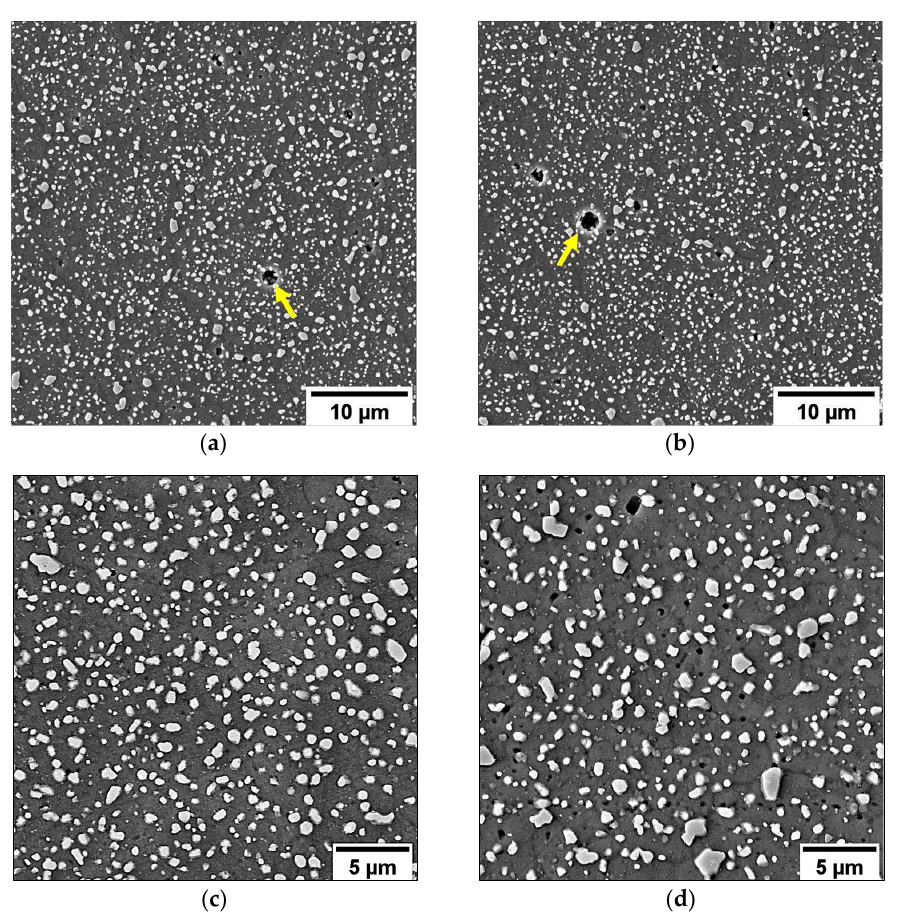
Figure 7. T6R microstructure observed on the transversal section of fatigue specimens: before high- temperature tests ( a , c ) and after 2 × 10 6 cycles (about 17 h) at 200 °C ( b , d ). Yellow arrows in ( a ) and ( b ) highlight gas pores.